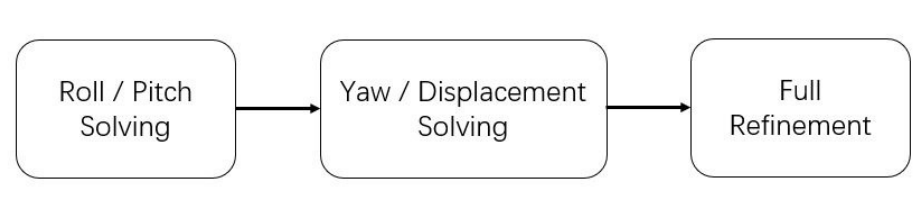
Figure 3. Hand-eye calibration equation diagram and extrinsic parameters analytical solution